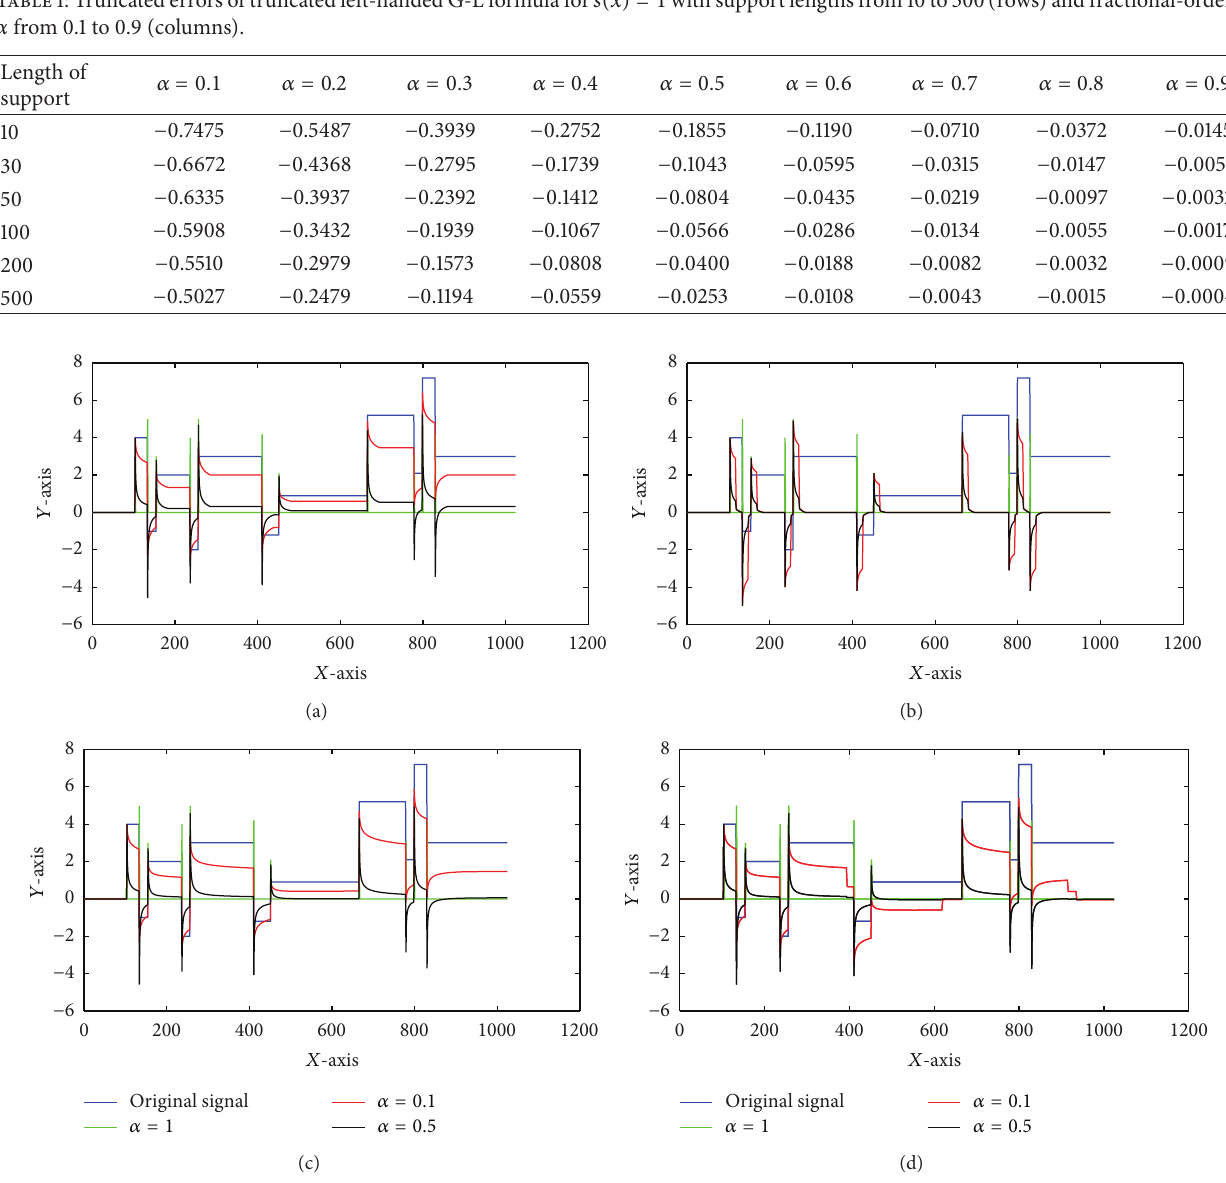
Figure 2: The original signal (blocks with 1024 samples, blue lines), its fractional derivatives of truncated G-L with different fractional orders ((a) and (c)), and its fractional derivatives of the new method with different fractional orders ((b) and (d)), where the support length of (a) and (b) is 30 and the support length of (c) and (d) is